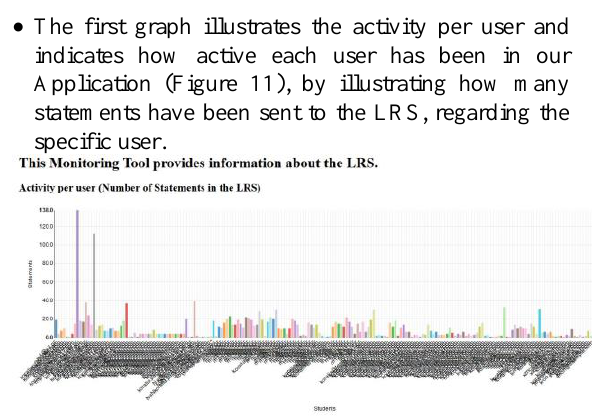
Figure 11. Activity per user in the LRS